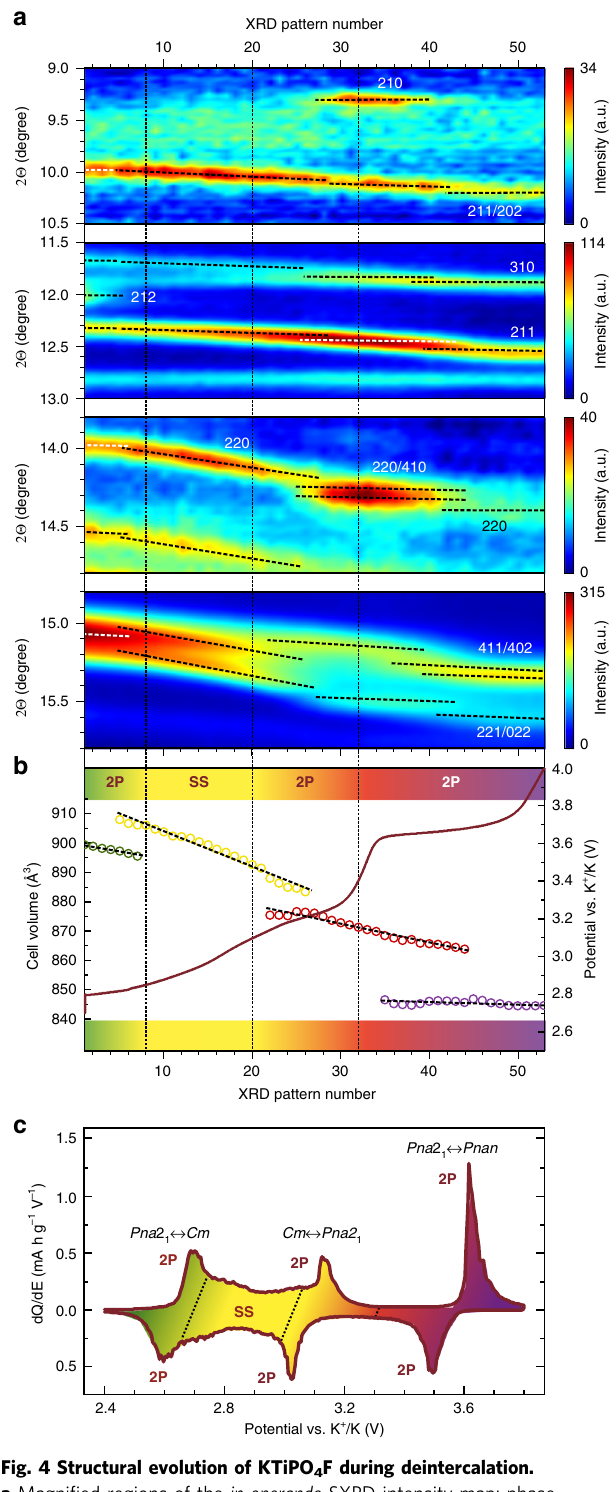
Fig. 4 Structural evolution of KTiPO 4 F during deintercalation. a Magni fi ed regions of the in operando SXPD intensity map: phase transformations. White and black dashed lines designate re fl ections related to particular phases. 2P — two-phase region, SS — solid-solution region. Vertical dashed lines show tentative borders of 2P and SS regions. b Cell volume evolution on charge as re fi ned from in operando SXPD data for K x TiPO 4 F with related charge galvanostatic curve. c dQ/dE plot showing potential ranges for solid-solution and multiple two-phase deintercalation